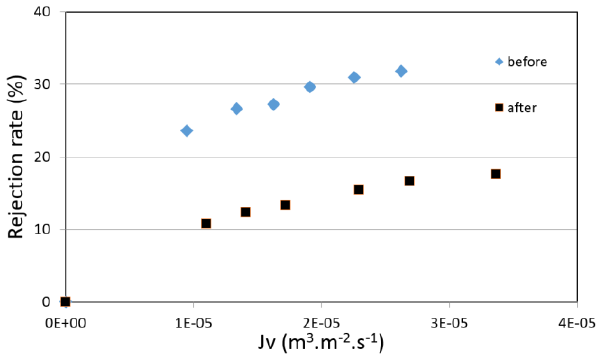
Figure 8. Rejection rates of NaF-water solutions vs. permeation flux (membrane 1) before and after the alkaline treatment.